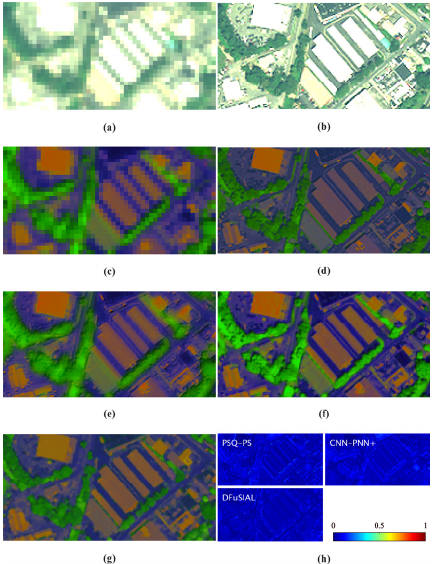
Figure 18. Zoom-in on the abundance fraction maps for three dominant EMs in the selected area for Test 5. ( a ) and ( b ) present RGB composites of the WorldView-2 in reduced and original SR of 7.36 m and 1.84 m, respectively. ( c ) and ( d ) present corresponding fraction maps as obtained using the spectral images with LSR 7.36 m and HSR 1.84 m (used as GT), respectively. ( e ), ( f ) and ( g ) present corresponding fraction maps with HSR 1.84 m, as obtained using the images retrieved by the PSQ-PS and CNN-PNN+ methods and as obtained by the proposed fusion method DFuSIAL, respectively. ( h ) present the corresponding area in the MAE maps of the fractions obtained by the examined methods.